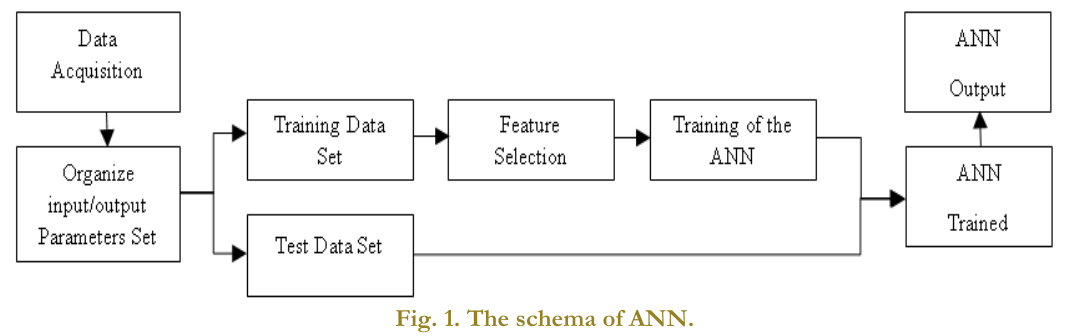
Fig. 1. The schema of